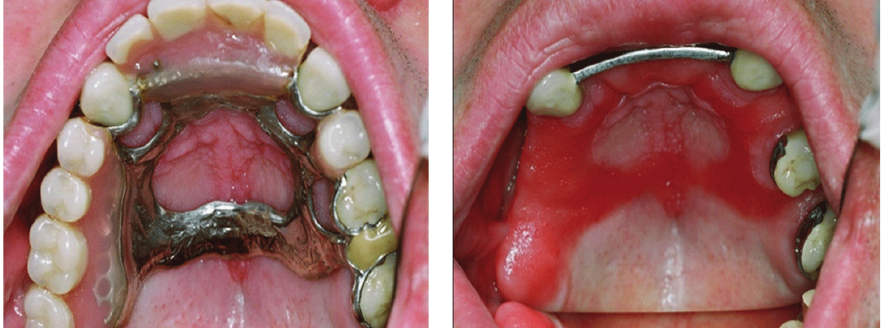
Figure 1: Inflammation of the oral mucosal tissues after removal of the